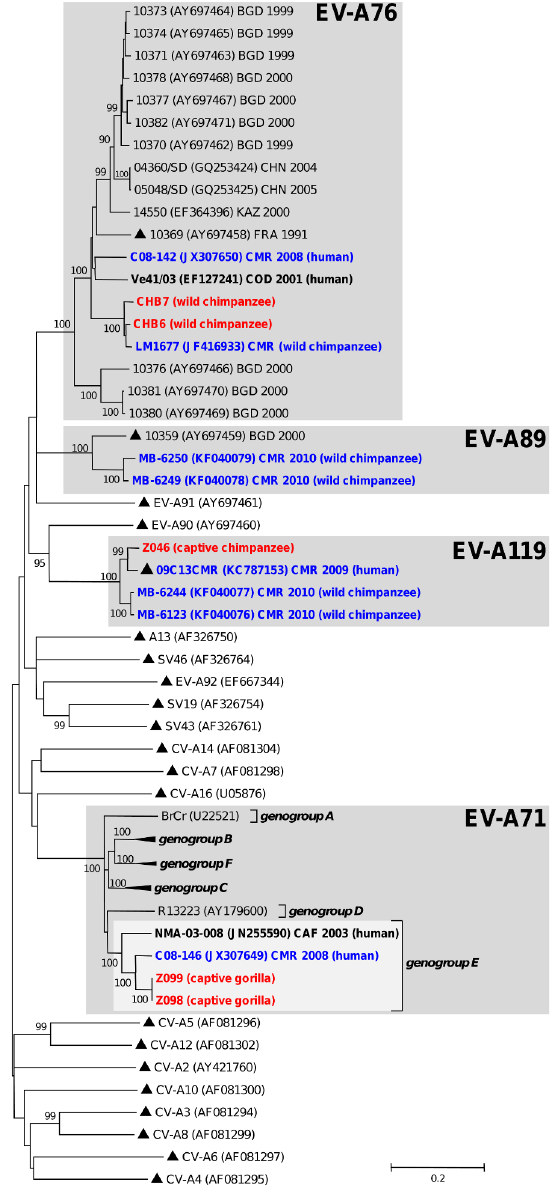
Figure 1. Phylogenetic relationships among Enterovirus A strains from human and non-human primates. The NJ tree is based on the alignment of the full-length VP1 sequences. Viruses of non-human primates’ origin are highlighted in bold red with reference to the host names in brackets. The year and country of isolation are indicated for EV-A71, EV-A76, EV-A89 and EV-A119, if known (BGD, Bangladesh; CAF, Central African Republic; CHN, China; CMR, Cameroon; COD, Democratic Republic of the Congo; FRA, France and KAZ, Kazakhstan). Strains previously reported in Cameroon (bold blue) and other central African countries (bold black) are indicated with host species in brackets. Prototype strains are highlighted by triangles ( m ). The scale is shown at the bottom as substitutions per site. Viruses belonging to enterovirus species commented in the text are gathered in grey-shaded